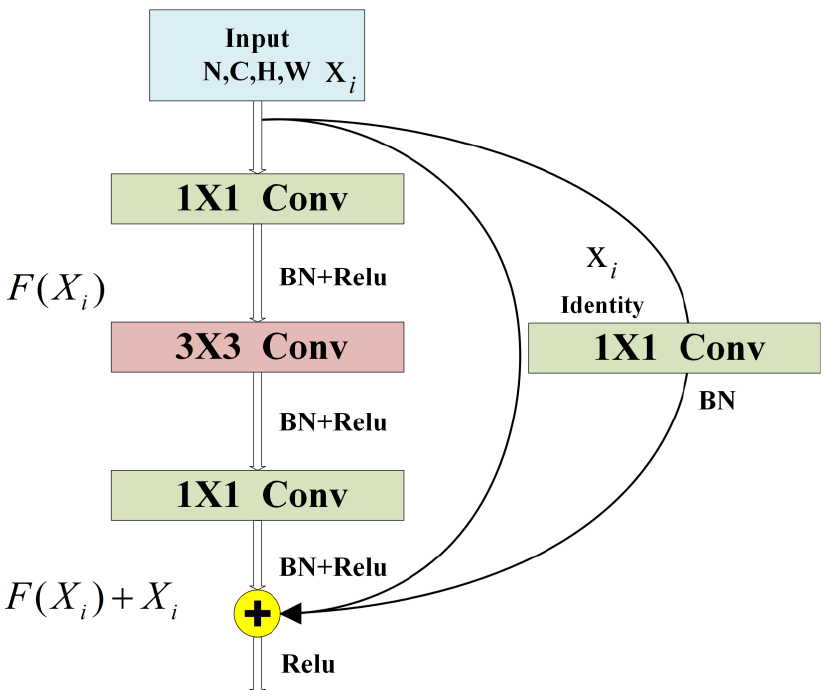
Figure 7. The architecture of the basic blocks of ResNet50. The line with 1X1 Conv represents the Conv block. It is used in the first place of every stage in ResNet50 to expand the channels of feature maps. The line without 1X1 Conv is the identity block, which is used in every stage following the Conv block.